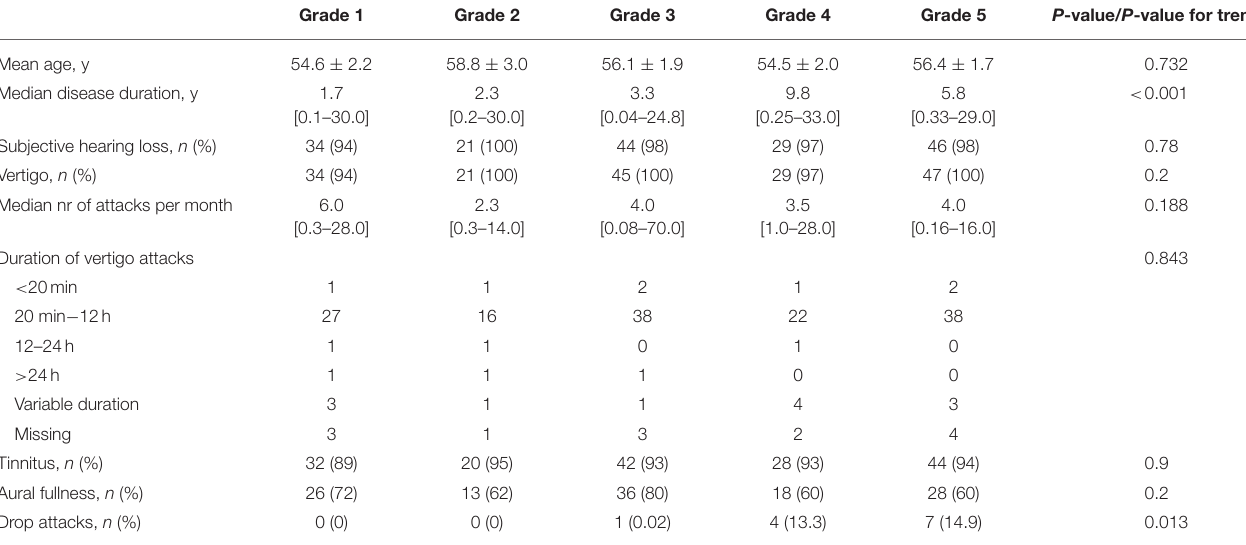
TABLE 5 | Clinical features in unilateral HED stratified by the summative EH score.